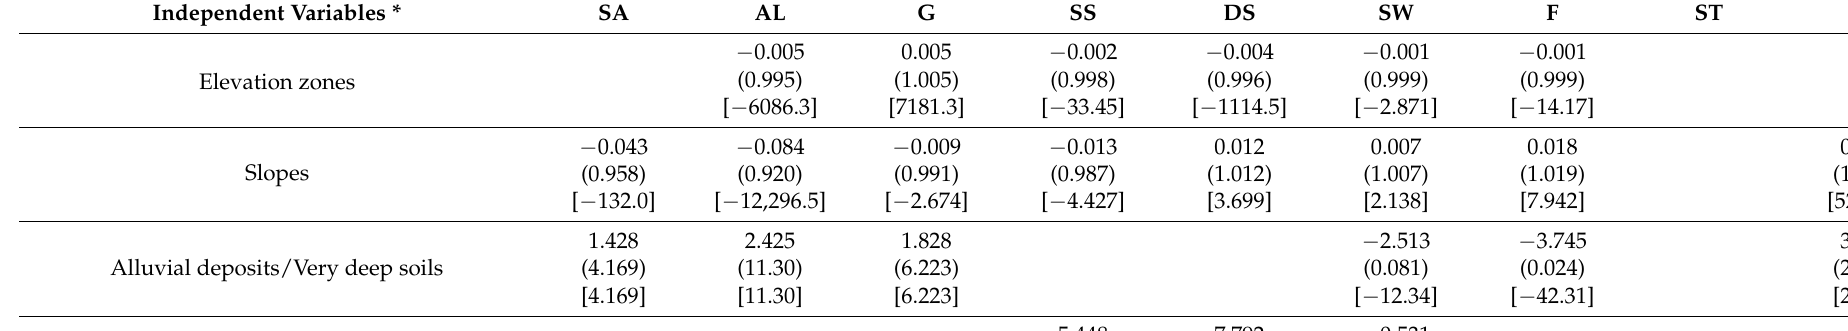
Table 4. Logistic regression coefficients (b-values), exp (b) (in parentheses), Relative Influence Index [in brackets] and AUC (Area Under the Curve). Only statistically significant coefficients appear, for significance level α = 0.02. (SA = Silvoarable, G = Grassland, AL = Agricultural land, SS = Sparse Shrubland, DS = Dense Shrubland, SW = Silvopastoral Woodland, F = Forest, ST = Settlements and BL = Barren Land). Independent Variables